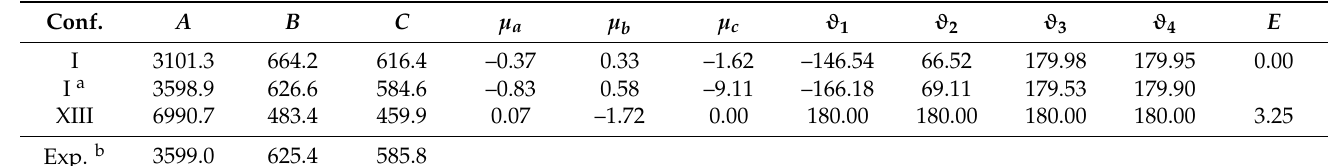
Table 1. Rotational constants (in MHz), dipole moment components (in Debye), dihedral angles (in degree), and energies relative to that of the lowest energy conformer I (E = − 424.5296788 Hartree) of the two observed conformers of MHO (I and XIII) calculated at the MP2/6-311++G(d,p) level of